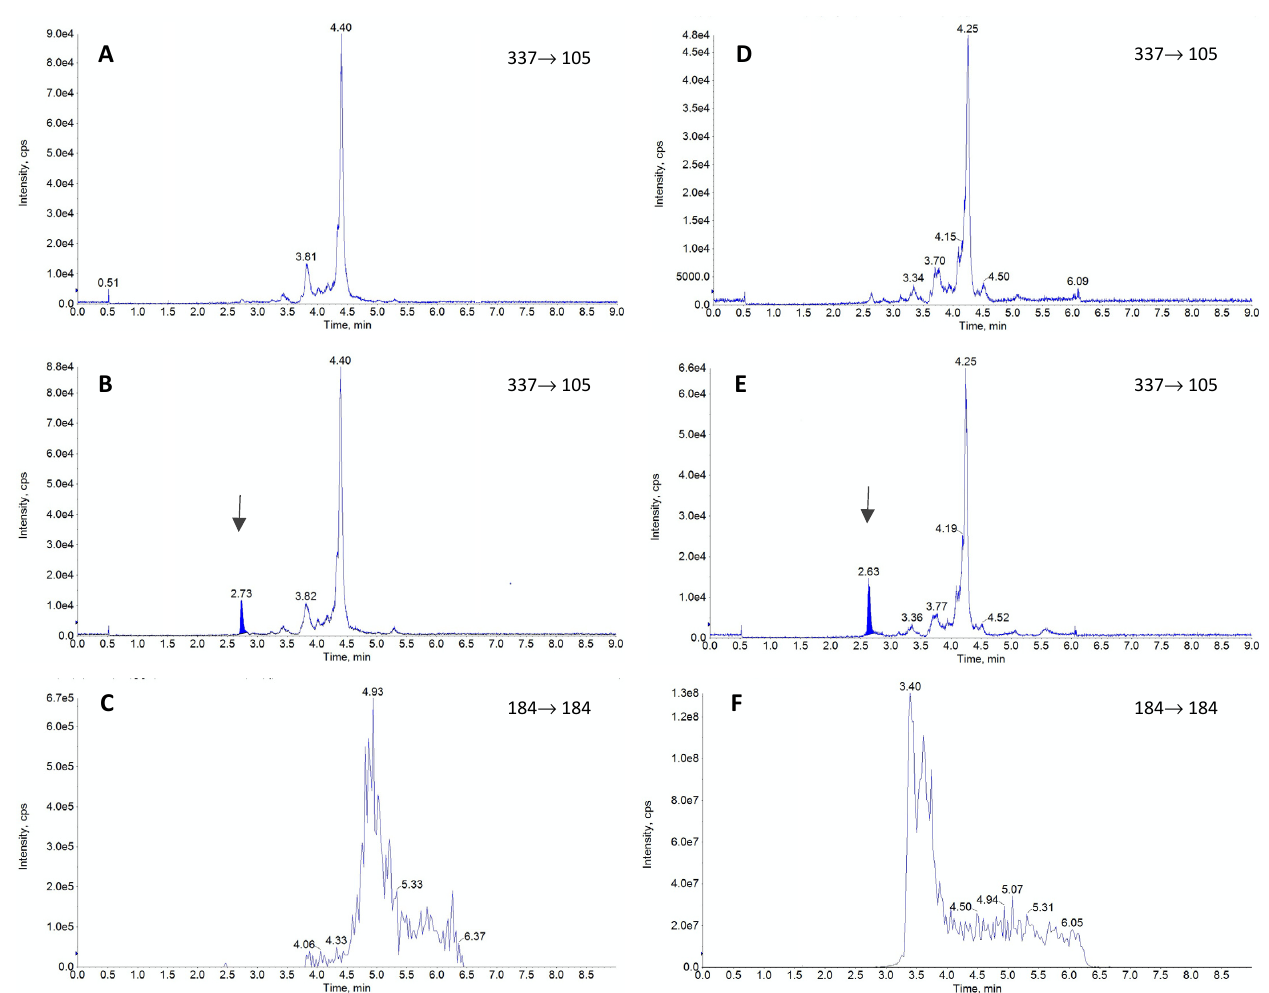
Figure 1. The representative chromatograms obtained during the validation of fentanyl (FEN). The blank sample ( A ), plasma sample containing FEN residues at the limit of quantification ( B ) and glycerophosphocholines (184 m / z ) ( C ) are shown for standard rabbit plasma. For comparison the same chromatograms are presented for lipemic plasma, including blank sample ( D ), sample with FEN addition at the limit of quantification level ( E ) and glycerophosphocholines ( F ). The peak for FEN is seen as a dark-blue shaded area and it’s retention time is indicated by the arrows (ca. 2.6 min).